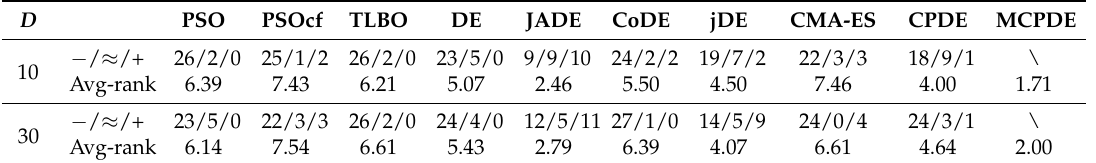
Table 7. Comparison of MCPDE with PSO, PSOcf, TLBO, DE, JADE, CoDE, jDE, CMA-ES and CPDE on the CEC2013 benchmarks ( D = 10 and 30